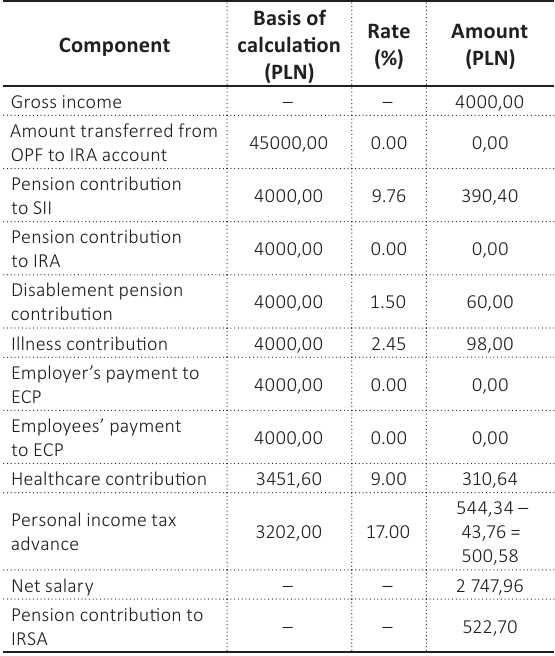
Table 11. Variant 4 – non-participation in ECP and membership in IRA